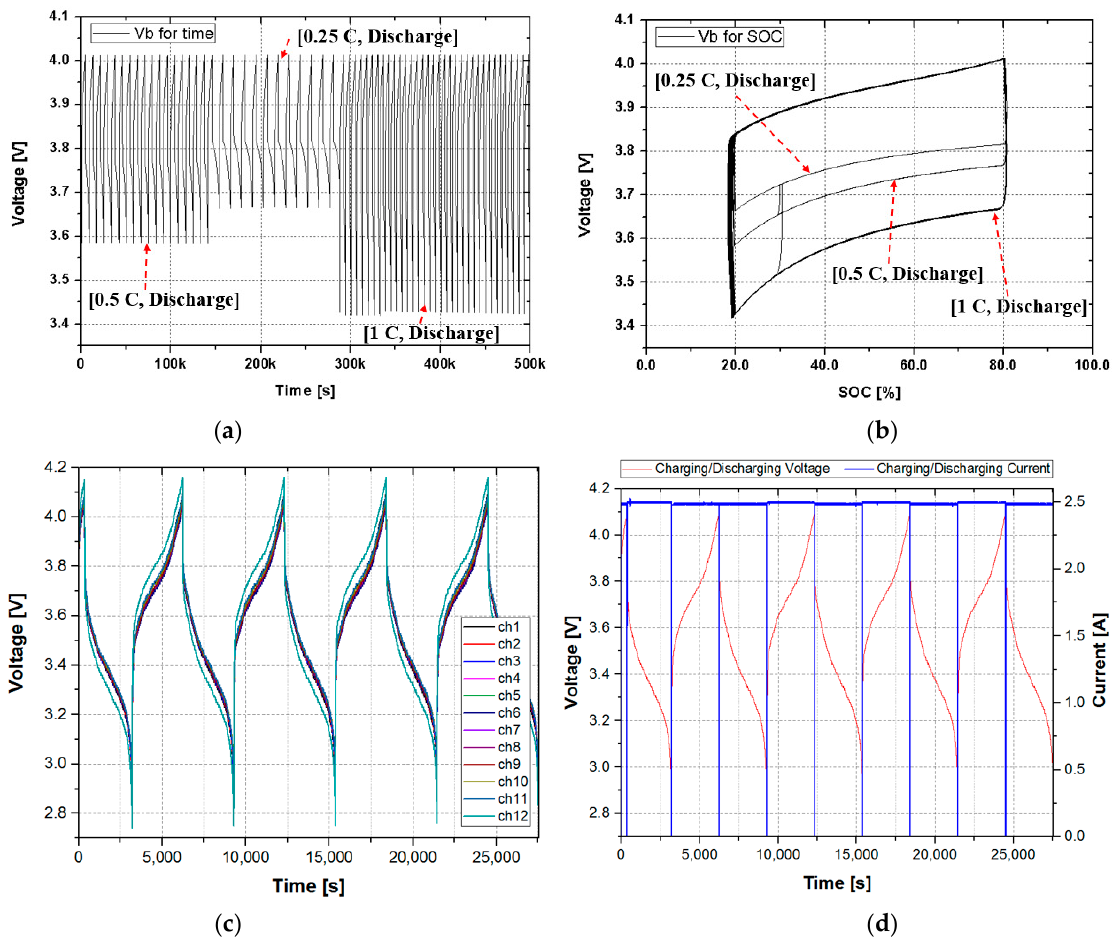
Figure 11. The comparison of the voltage against time and the voltage against SOC according to the discharge current change: ( a ) graph of the voltage change against time at 0.25 C, 0.5 C, and 1 C; ( b ) graph of voltage change against SOC at 0.25 C, 0.5 C, and 1 C; ( c ) graph of voltage change for 12 cells; ( d ) and graph of voltage change and current for channel 1.